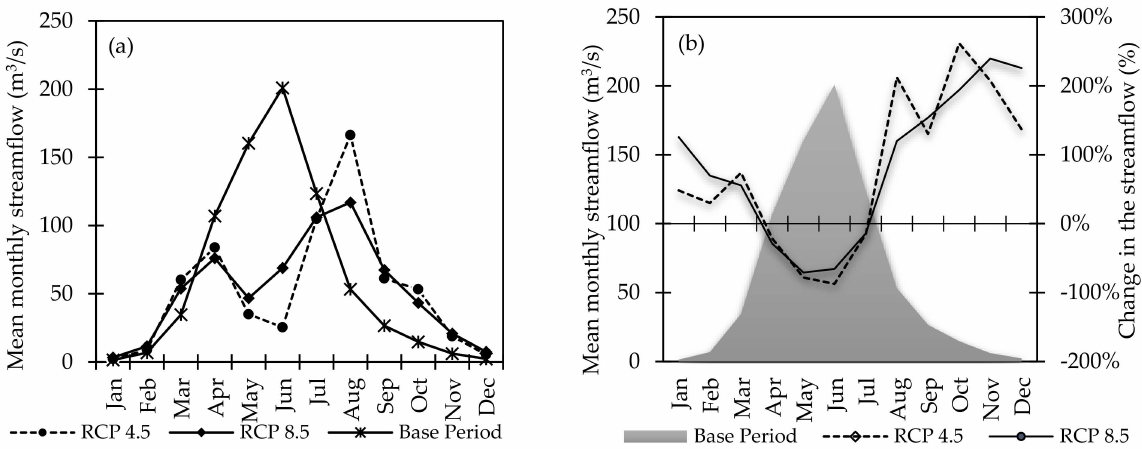
Figure 10. Comparative analysis of the monthly streamflow, ( a ) hydrograph analysis of the base period and climate change scenarios; ( b ) percent change in streamflow under the RCP 4.5 and 8.5 compared to the base period